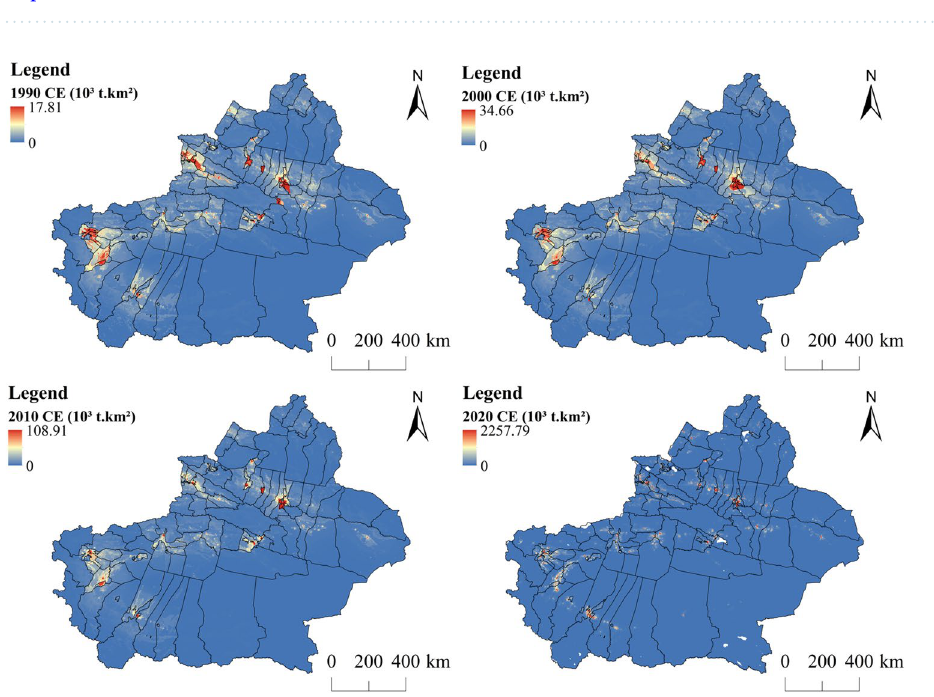
Figure 9. Changes in Xinjiang Carbon Emissions. Map generated with ArcGIS 10.8 (ESRI). URL: https:// suppo rt. esri. com/ en/ Produ cts/ Deskt op/ arcgis- deskt op/